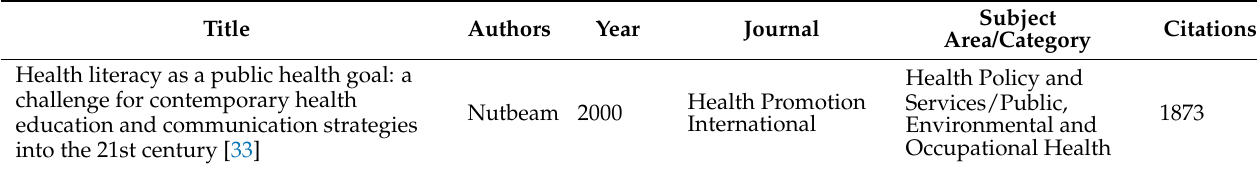
Table 2. Most cited papers on Health Literacy and Health Education in Web of Science Core Collection (data from Web of Science).